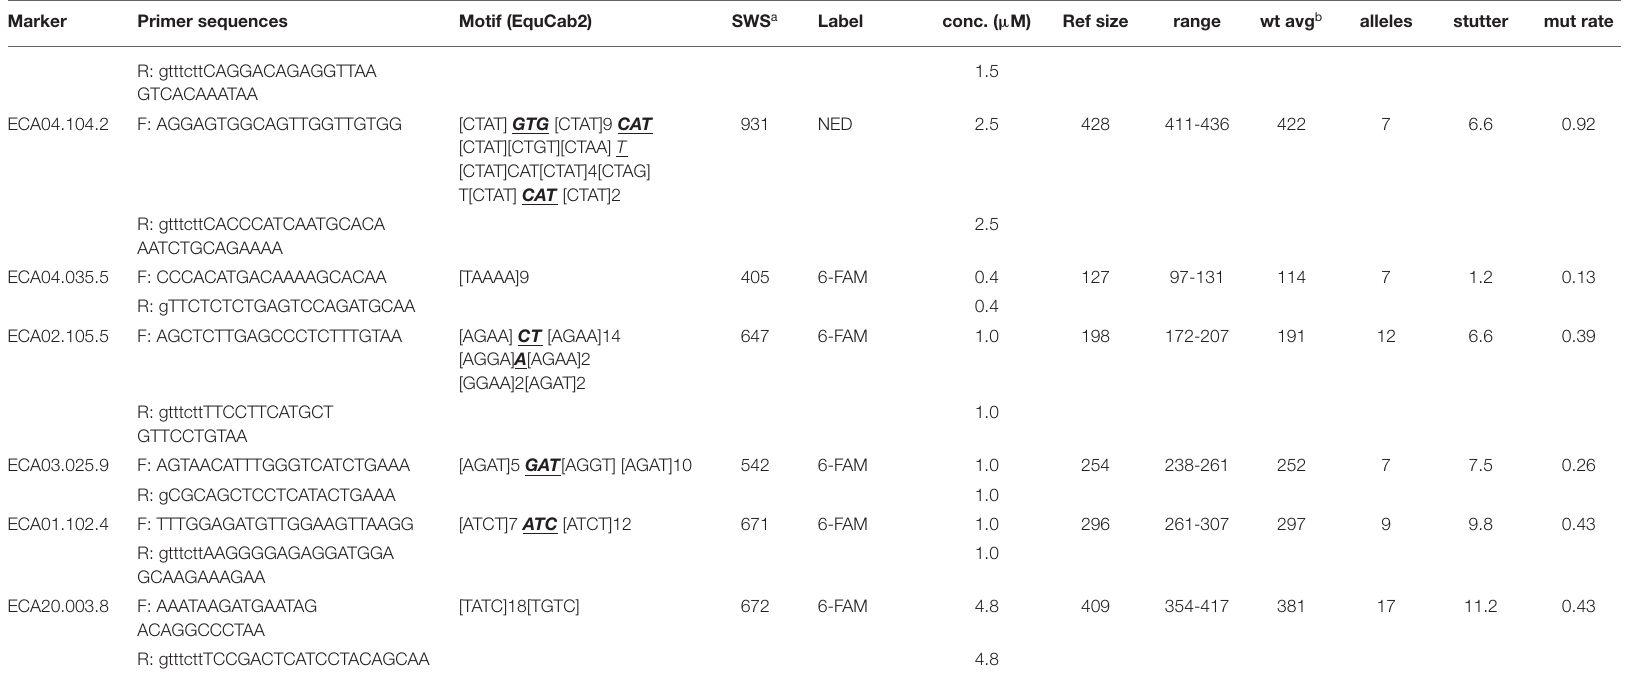
The table is sorted by primer label (HEX, NED, and 6-FAM) and then by the amplicon size predicted from the reference genome (Ref size). Markers are named by the chromosome upon which they reside (Eca, Equus caballus), followed by the megabase position for the repeat from the horse 2007 (EquCAb2) build. Lower case letters within the primer sequences indicate nucleotides that are not found in the horse reference genome; these nucleotides are primarily “pigtails” to suppress split peaks (20). The motif is indicated by the sequence found in TRF track in the UCSC Genome Browser. The TRF track follows the nomenclature recommendations of the DNA Commission of the International Society of Forensic Genetics better than that of RepeatMasker (21, 22). Numbers for the motif sequences are from the horse reference genome, and bold underlined letters are not included in the repeat count (see Figure 1 ). The reference genome size (ref size) includes the additional non-templated adenine that is attached via the terminal transferase activity of the Taq polymerase (20). The concentration is the final value used in our implementation of the multiplex panel. The stutter is given in the percent of the height of the main peak. The number for each marker is the average stutter across all measurements. mut rate, This is the predicted mutation rate based upon the relationship of the SW score with the human mutation rate, assuming that the horse mutation rate will be similar (Venta, unpublished results). The mutation rate for Eca04a (ECA04.104.2) is likely to be too high because much of the repeat region is imperfect and it is very long (see Discussion). a SWS, Smith Waterman score, as obtained from the UCSC Genome Browser for equCab2. b wt avg, weighted average in base pairs, as is the